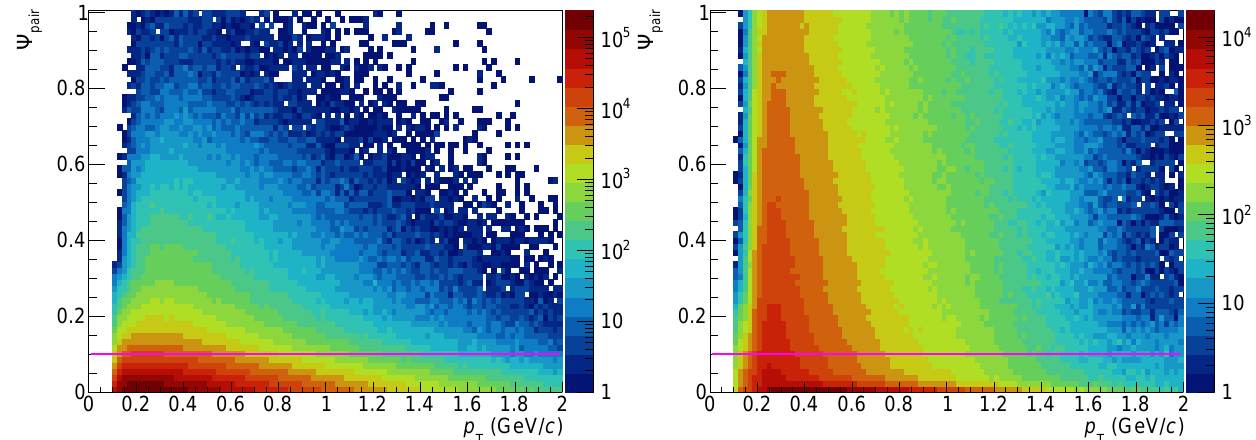
Figure 7. Distributions of signal ( left ) and background ( right ) pairs as a function of the Ψ pair angle and transverse momentum of the reconstructed pair. Selection limits are shown with magenta lines.